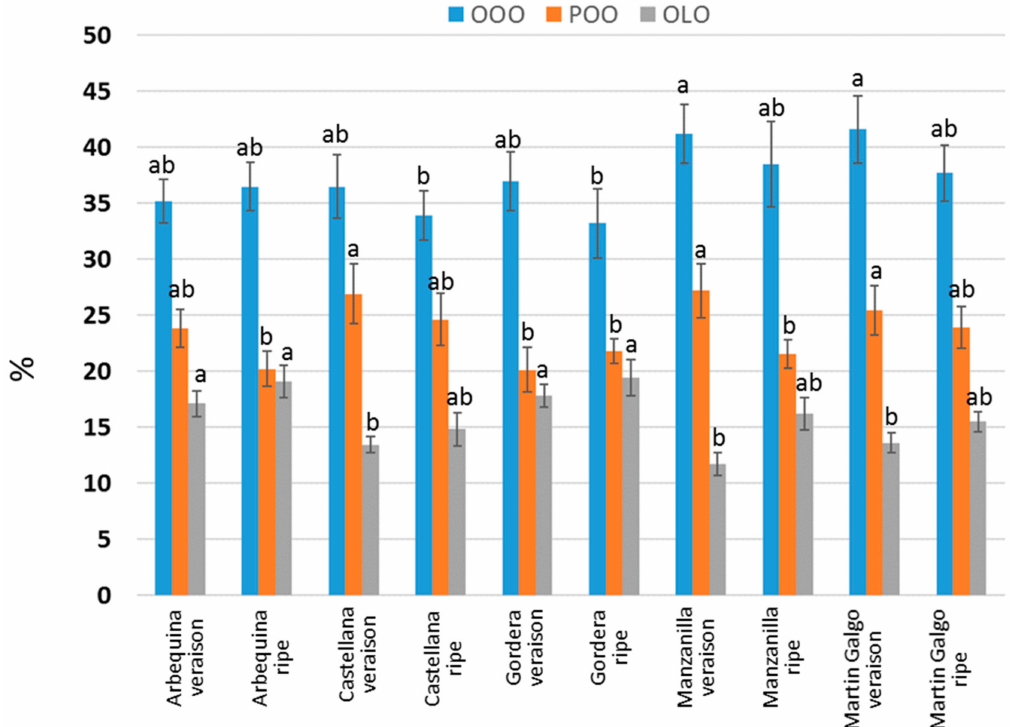
Figure 4. Main triglycerides present in the samples of virgin olive oil analyzed, from the di ff erent olive varieties grown in the study area, collected at di ff erent stages of maturation. Triglyceride composition in which L represents linoleic acid; P, palmitic acid and O, oleic acid. Di ff erent letters on the figure indicate significant di ff erences among cultivars. Duncan test ( p <